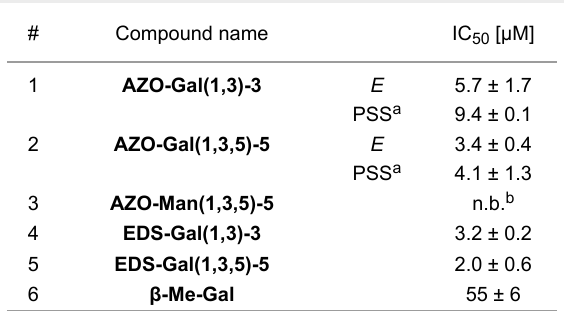
Table 2: IC 50 values obtained by SPR inhibition/competition assays of the photoswitchable glycooligomers and control